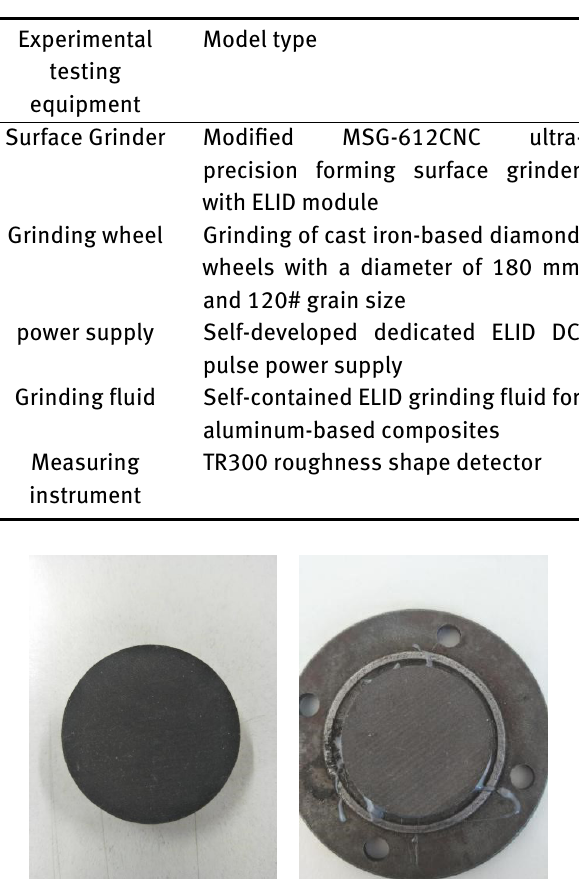
Table 2: Experimental and testing equipment